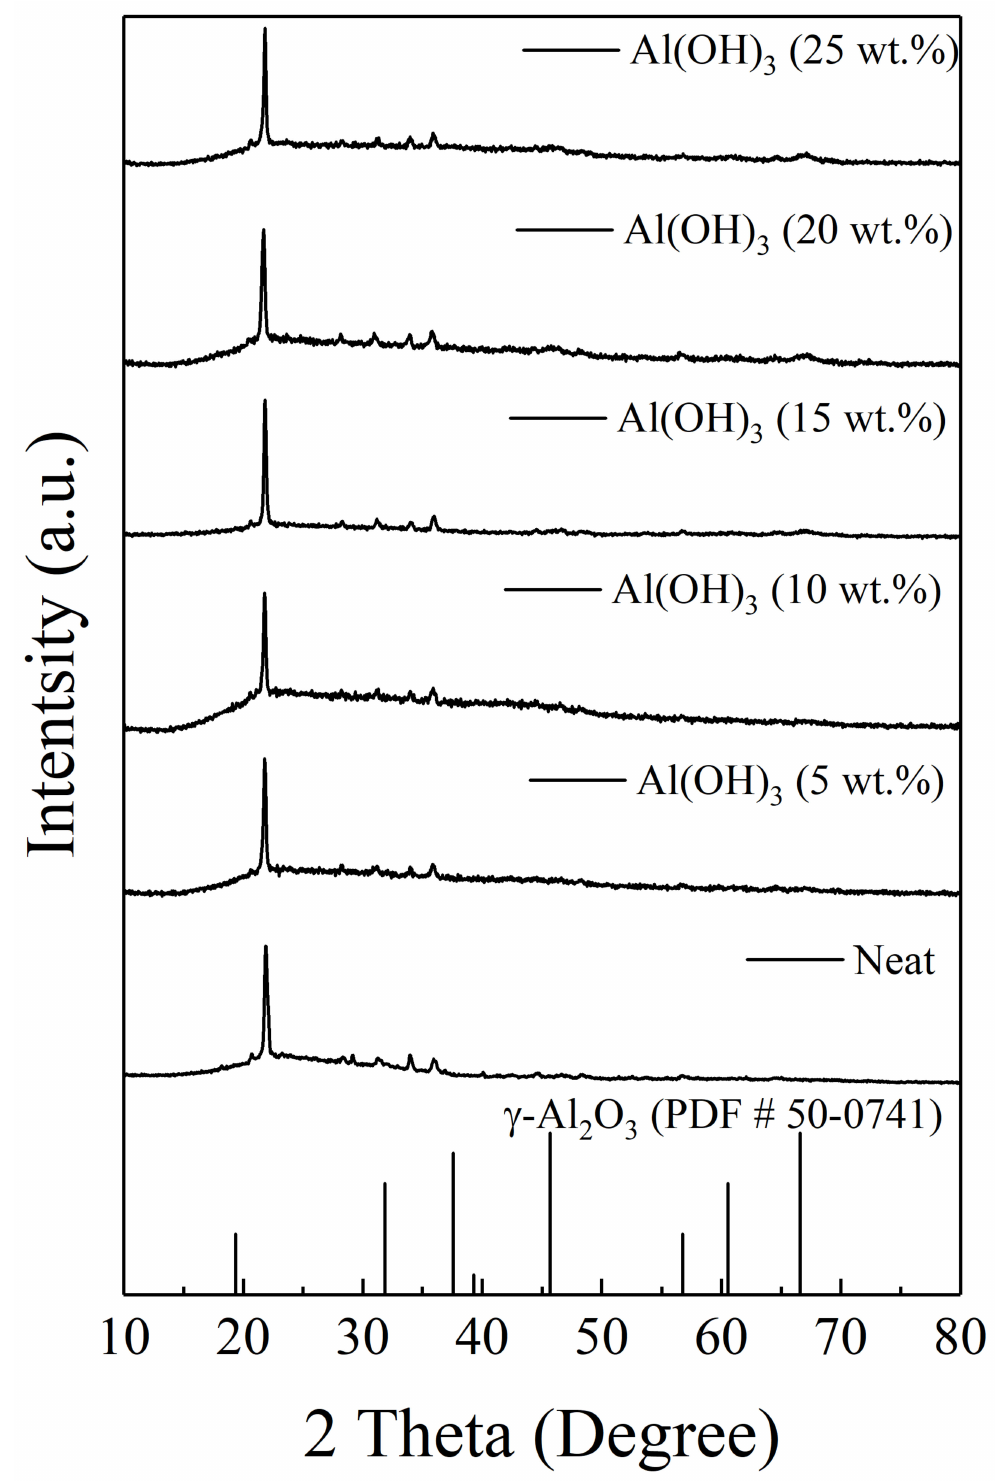
Figure 10. XRD images of intumescent flame-resistant coatings after thermal heating with the optimal ratio of sodium silicate, ammonium polyphosphate, pentaerythritol, and additional 5, 10, 15, 20, and 25 wt.% of Al(OH) 3 ,